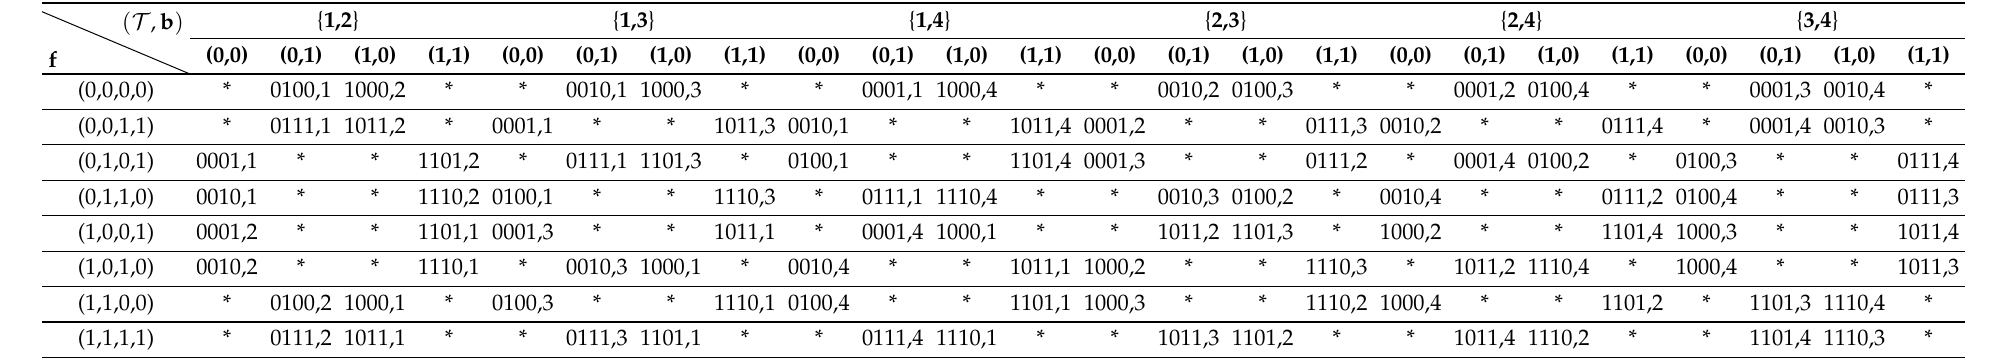
Table 2. The ( 24,8,4,32 )